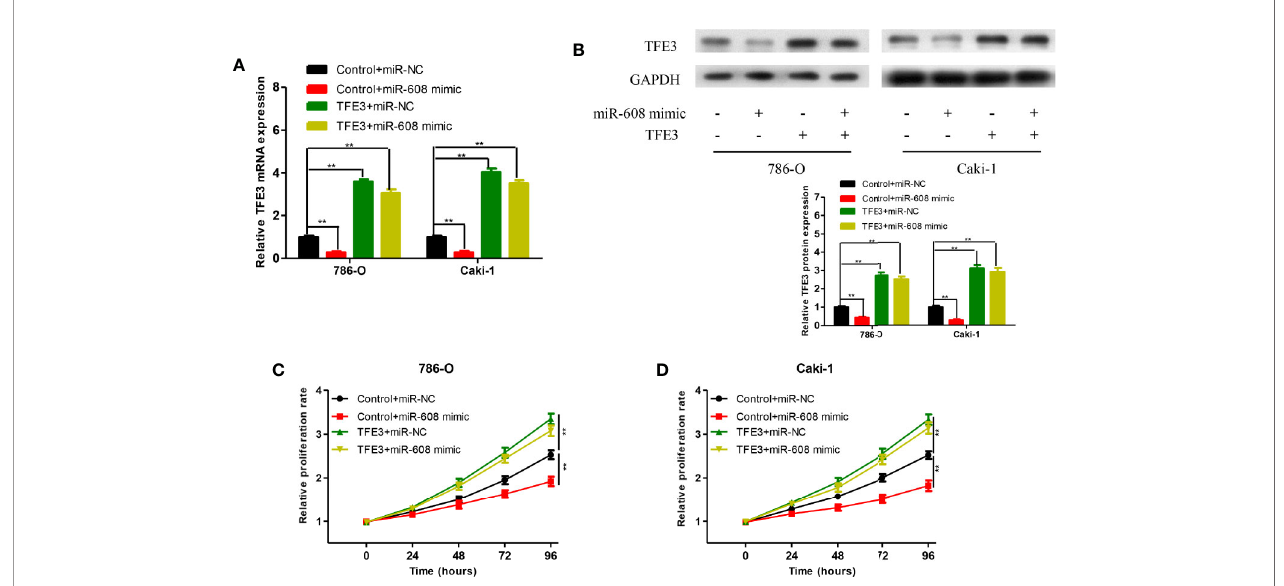
FIGURE 9 | TFE3 mRNA (A) and protein (B) expression in the 786-O and Caki-1 cells transfected with Control+miR-NC, Control+miR-608 mimic, TFE3+miR-NC, or TFE3+miR-608 mimic. The 786-O (C) and Caki-1 (D) cells transfected with Control+miR-NC, Control+miR-608 mimic, TFE3+miR-NC, or TFE3+miR-608 mimic, and the cell proliferation in each group was detected by CCK-8. (*** P < 0.001, ** P < 0.01, * P <